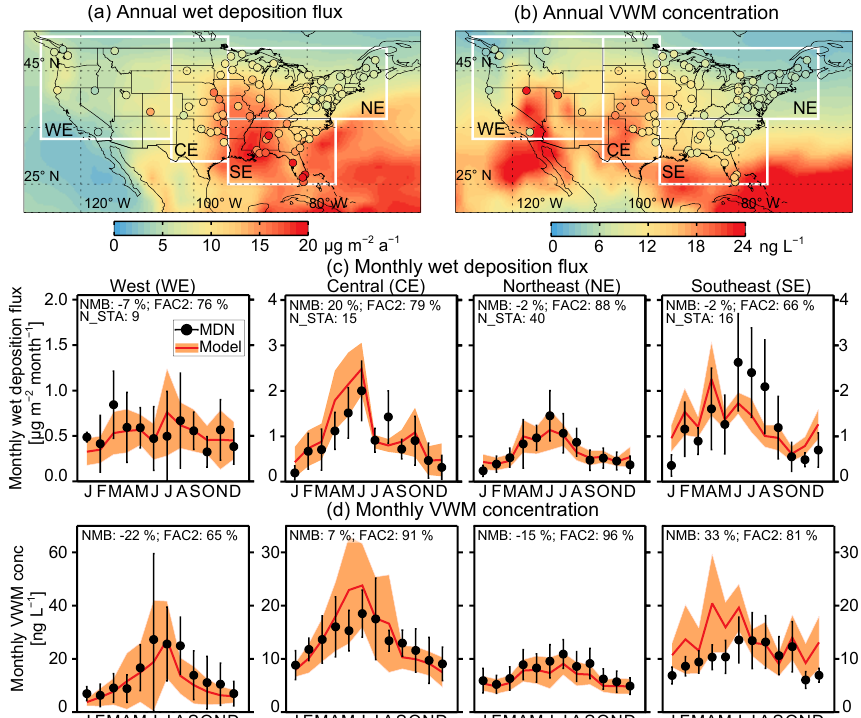
Figure 1. (a) Annual Hg(II) wet deposition fluxes and (b) volume-weighted mean (VWM) mercury concentrations over the US for 2013– 2014. The map backgrounds show the GEOS-Chem results and the filled circles show the Mercury Deposition Network (MDN) measure- ments. The bottom two rows ( c , d ) show the seasonal variations in wet deposition and VWM concentrations for the four regions marked by white boxes in (a) and (b) : west (WE), central (CE), northeast (NE), and southeast (SE). Black circles and error bars show the observed means and standard deviations. The red lines and orange shading are for the modeled means and standard deviations. Each panel displays the normalized mean bias (NMB) and the percentage of model–observation pairs within a factor of 2 of each other (FAC2). The number of stations in each region (N_STA) is also shown. Note the different scales on the y axis for the WE region relative to the other regions ( c and d ).